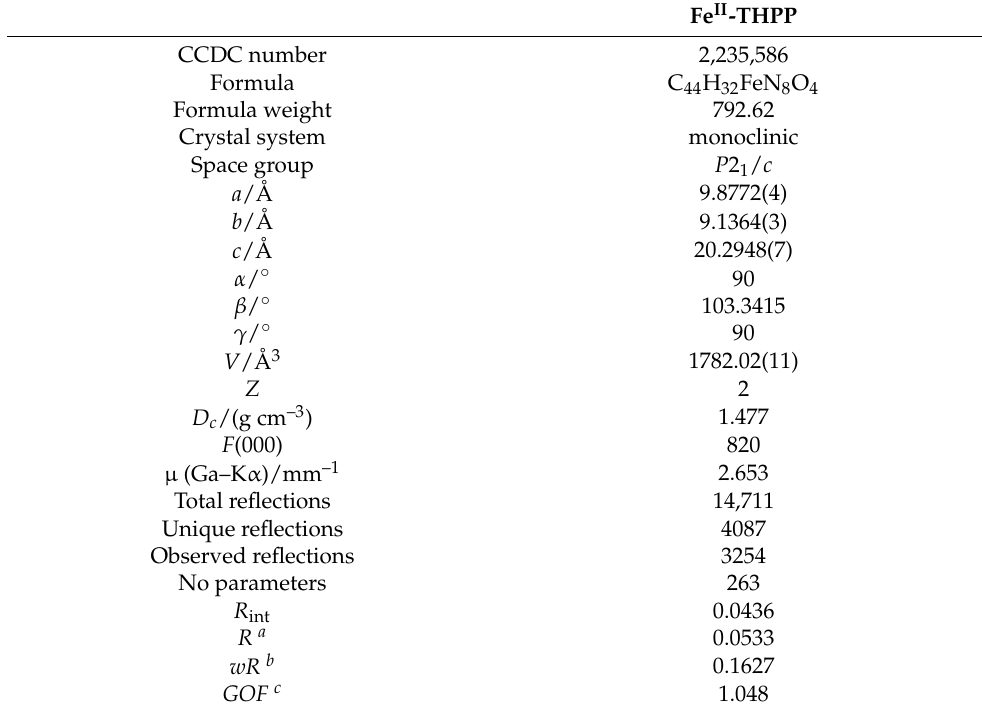
Figure 1. Top view ( a ) and side view ( b ) of the single-crystal structure of Fe II -THPP. All H atoms are omitted. In ( a ), the porphyrin skeleton, as well as the pyridinemethanol moieties propagating along different directions are distinguished by different colors for clarity. In ( b ), four consecutive 2D layers are distinguished by orange and bamboo colors. Color legend for ( a ): Fe (dark magenta), N (light blue), O (red), and C (akin to the bond color of the respective moiety). Table 1. Crystal data and structure refinement parameters for Fe II